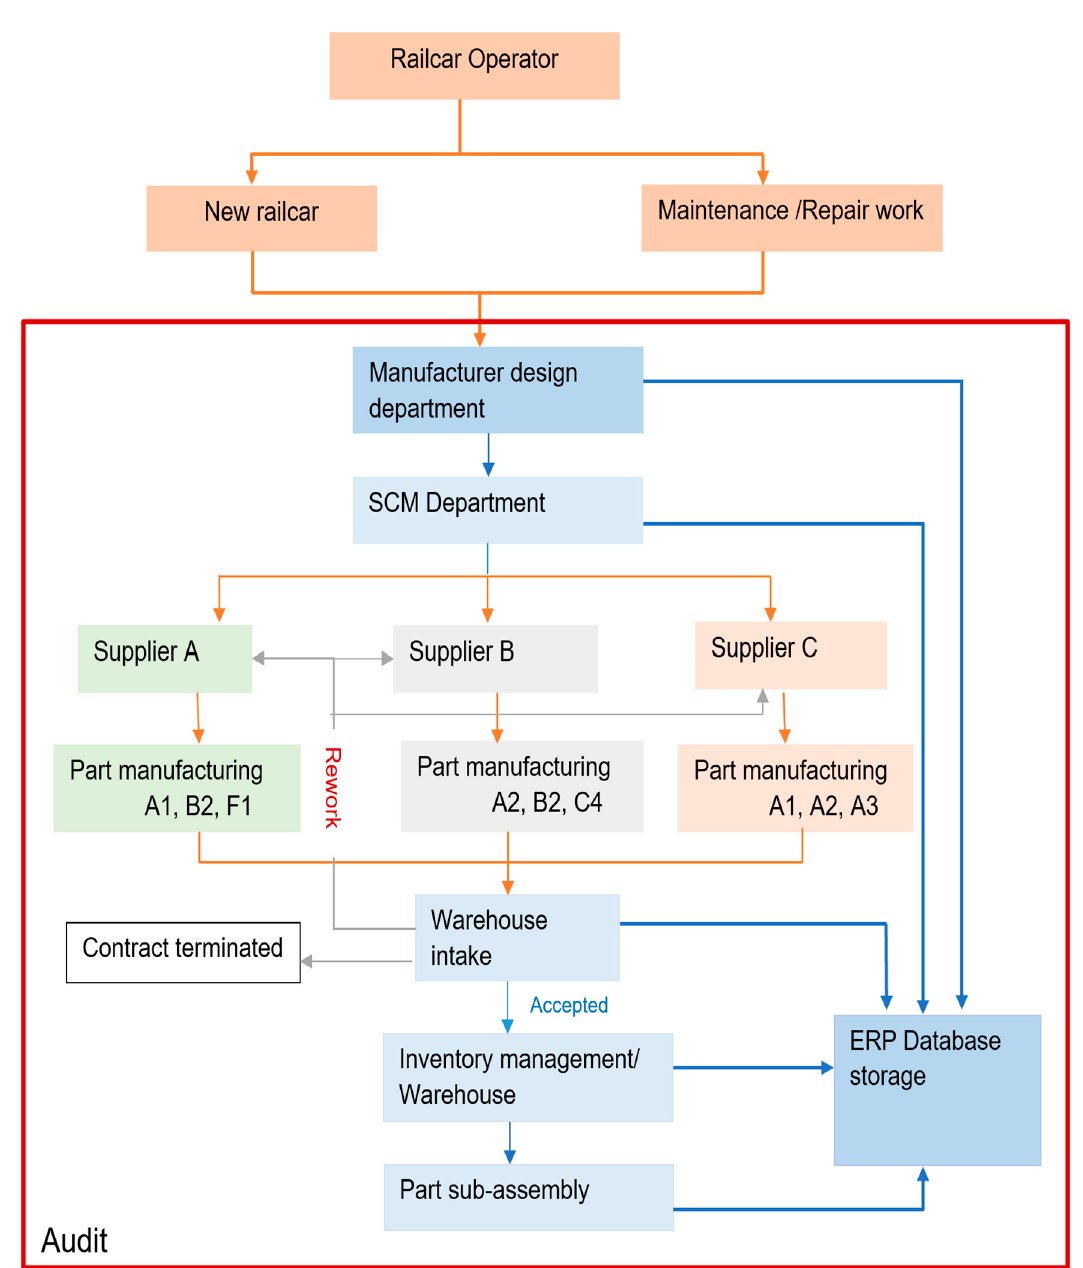
Figure 3. SCM process for railcar manufacturing of boxed flat sheet parts for railcar assembly.